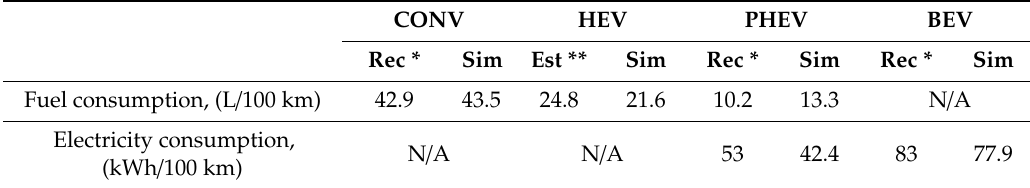
Table 3. Recorded and simulated relative fuel and electricity consumptions for di ff erent bus types and full recording